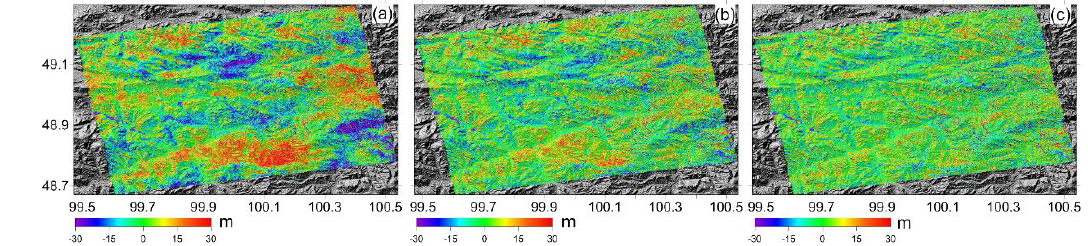
Figure 16. The elevation difference distribution ( a ) without atmospheric correction; ( b ) with Shirzaei’s atmospheric correction method; and ( c ) with MRWCA atmospheric correction.